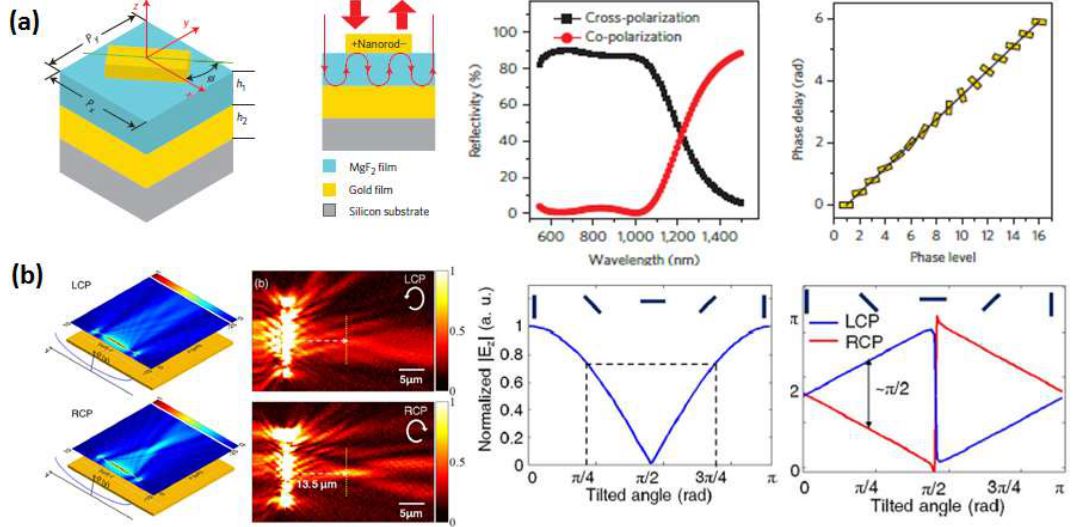
Figure 3: Left-to-right: (a) From [78]: Unit cell of a nanorod supporting two resonances under orthogonal polarizations with π phase sepa- ration. By introducing a space variant change in orientation, a geometric phase ranging from 0 to 2 π can be imparted to incident light. This frees up the design of the antenna resonances to maximize reflection. The current scheme utilizes a mirror to achieve ~90% reflection efl- ciency in the visible. (b) From [84]: A similar application of the Berry phase principle for the manipulation and focusing of surface plasmon beams via rectangular nano-slits. However due to lack of helicity of the plasmons, the phase change that can be achieved with orienta- tion changes is only π . Reprinted with permission from Refs [78] and [84]. Copyright 2015 Nature Publishing Group, 2015 Optical Society of